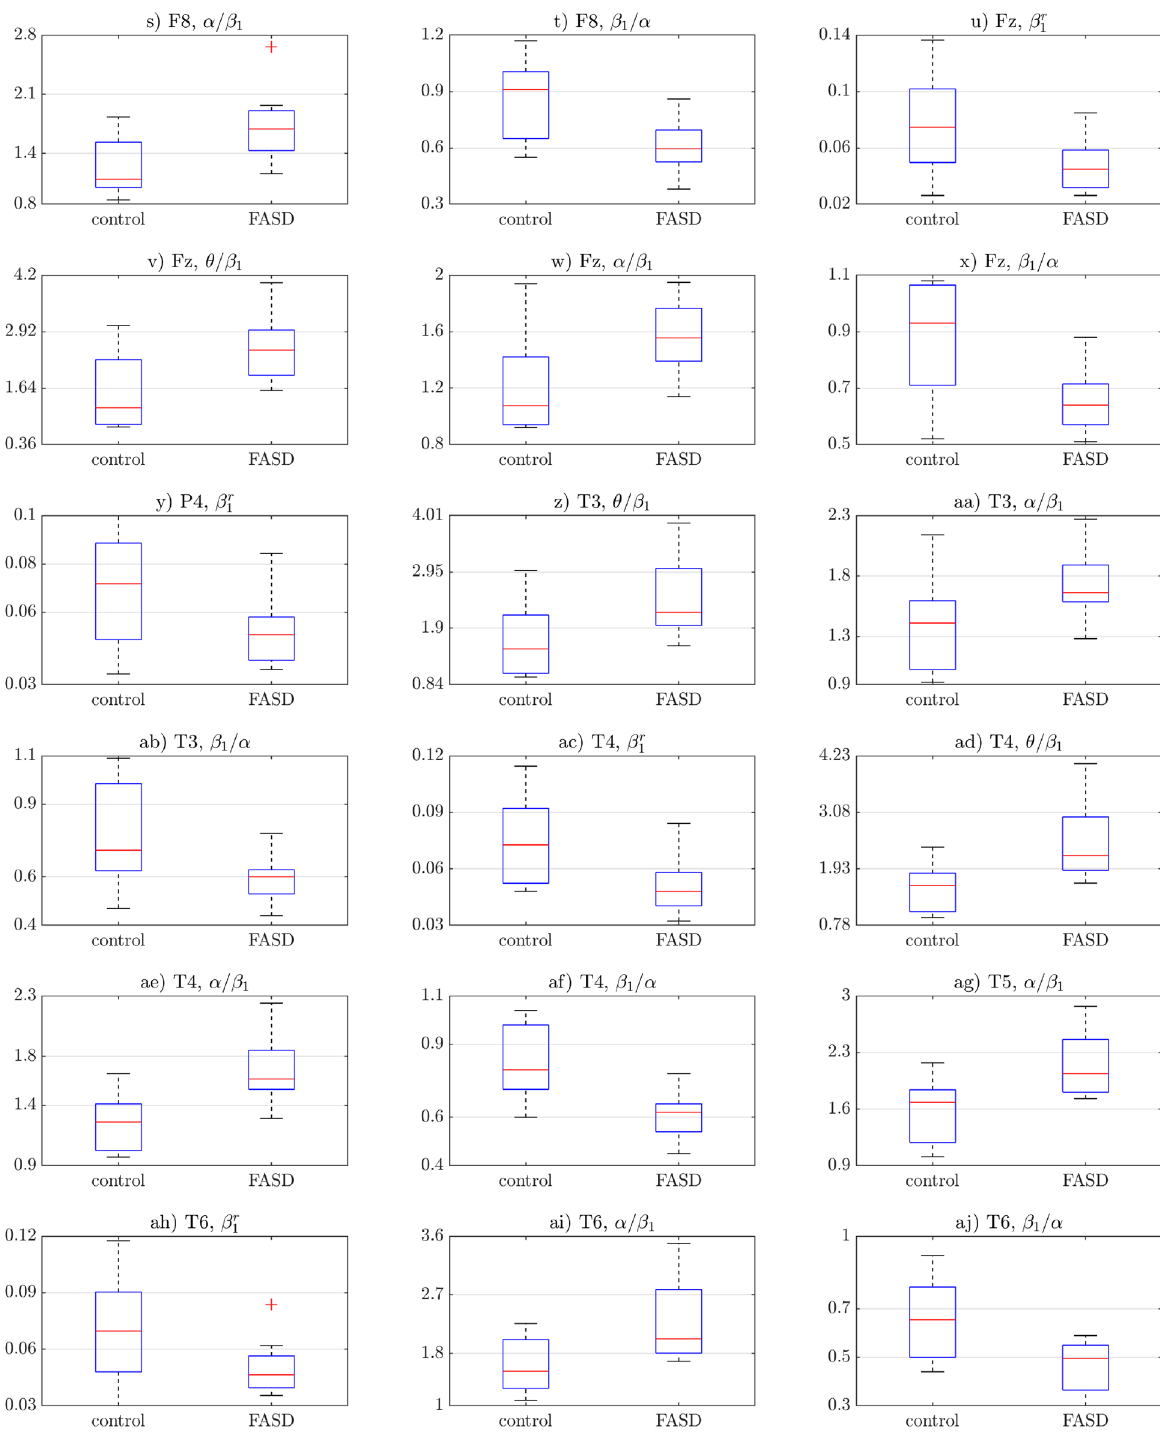
Figure 2. The second part of statistically significant features’ boxplots. See the first part on Fig.